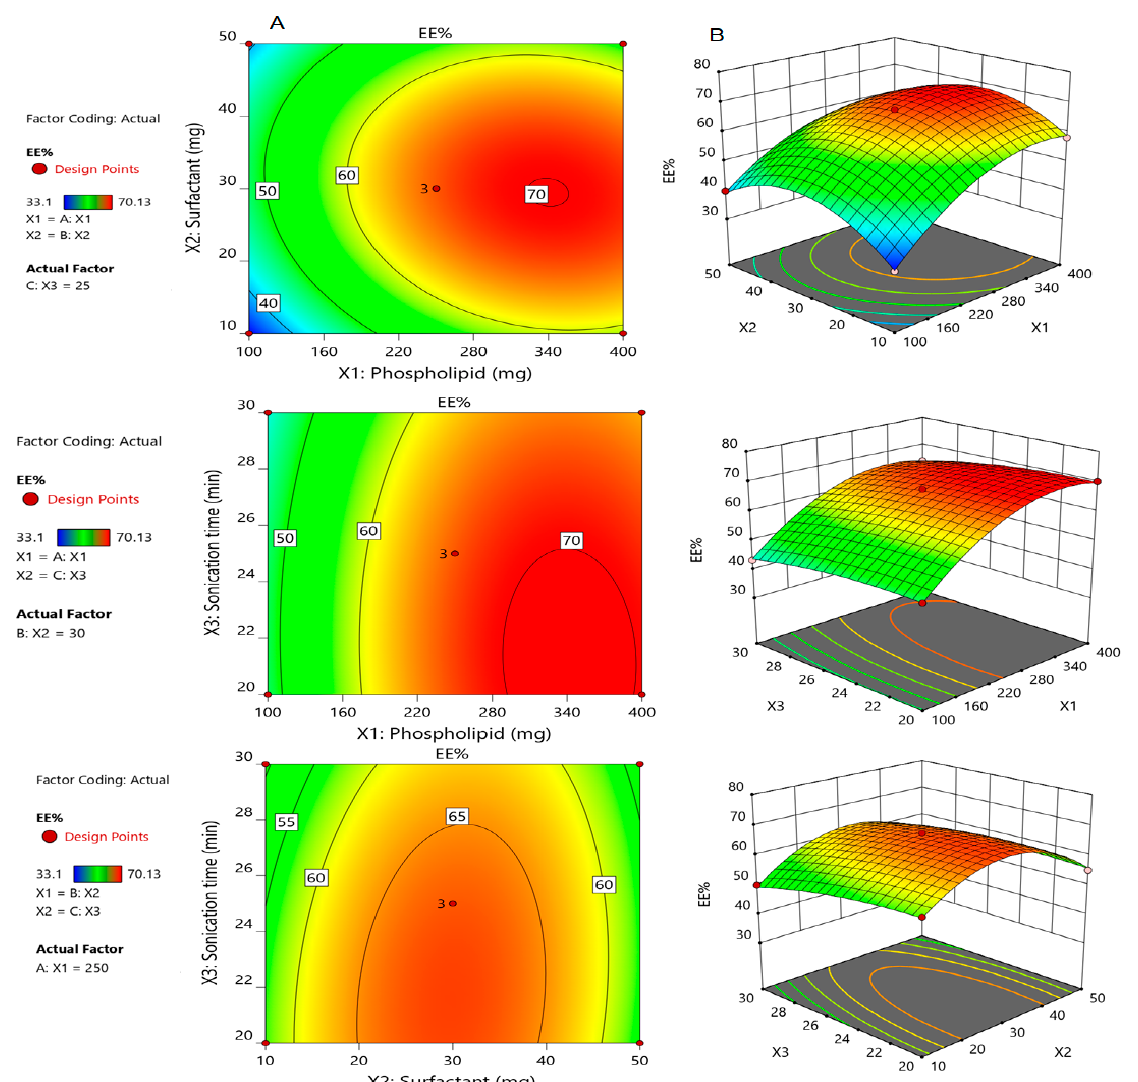
Figure 1. Contour plots ( A ) and corresponding response surface plots ( B ) which show effects of the independent variables on encapsulation efficiency (Y 1 ). Two independent variables are considered at a time, while the third one remains constant.